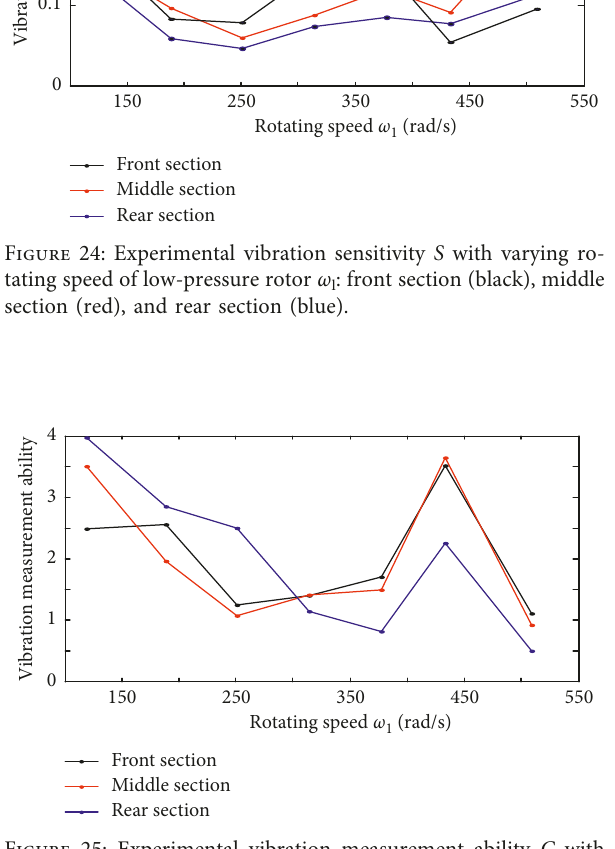
Figure 25: Experimental vibration measurement ability C with varying rotating speed of low-pressure rotor ω l : front section (black), middle section (red), and rear section